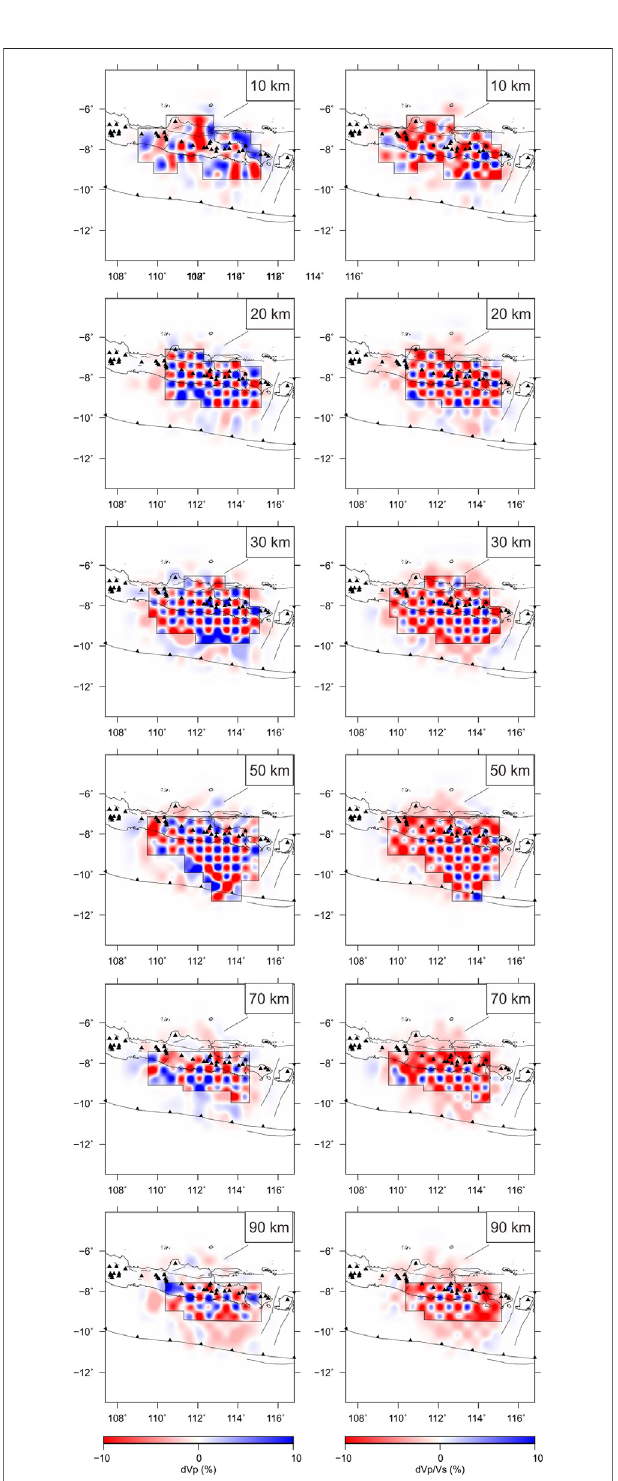
FIGURE2| Results of checkerboard resolution test for Vp and Vp/Vs ratio at depths of 10 – 90 km beneath the study area. Blue and red colors represent positive and negative perturbations relative to the initial model, respectively. Dashed polygons are the area recovered by this study. Red lines and triangles indicate the fault and volcano distribution,